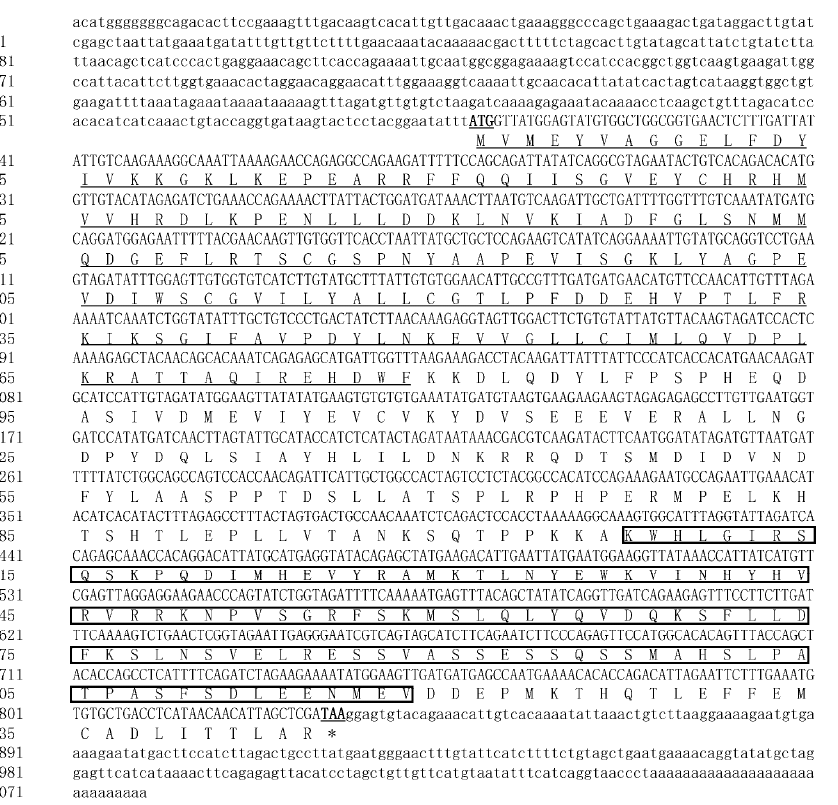
Figure 3. The nucleotide and predicted protein sequences of McAMPK γ . The black-framed region represents the low complexity domain, and the underlined areas represent the four CBS domain repeats.